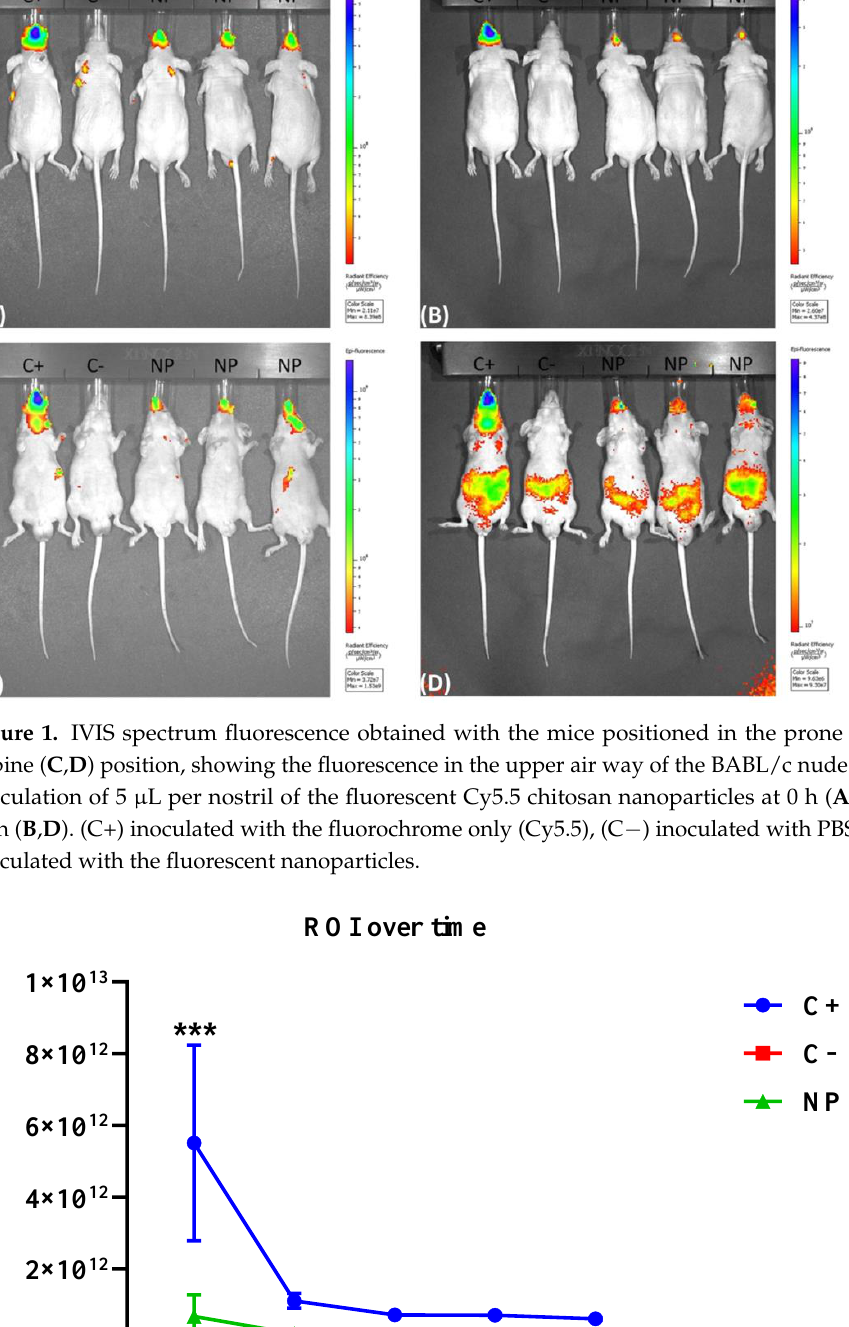
Figure 2. Fluorescent intensity of the region of interest (ROI) over time, showing that the fluorescence